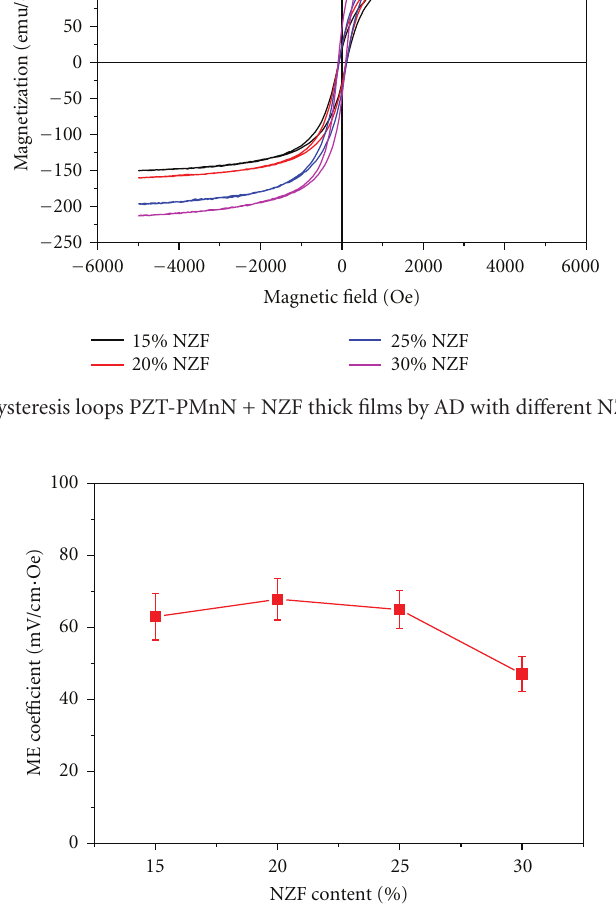
Figure 10: Maximum ME coe ffi cient of PZT-PMnN + NZF nanocomposite films by AD as a function of NZF content,